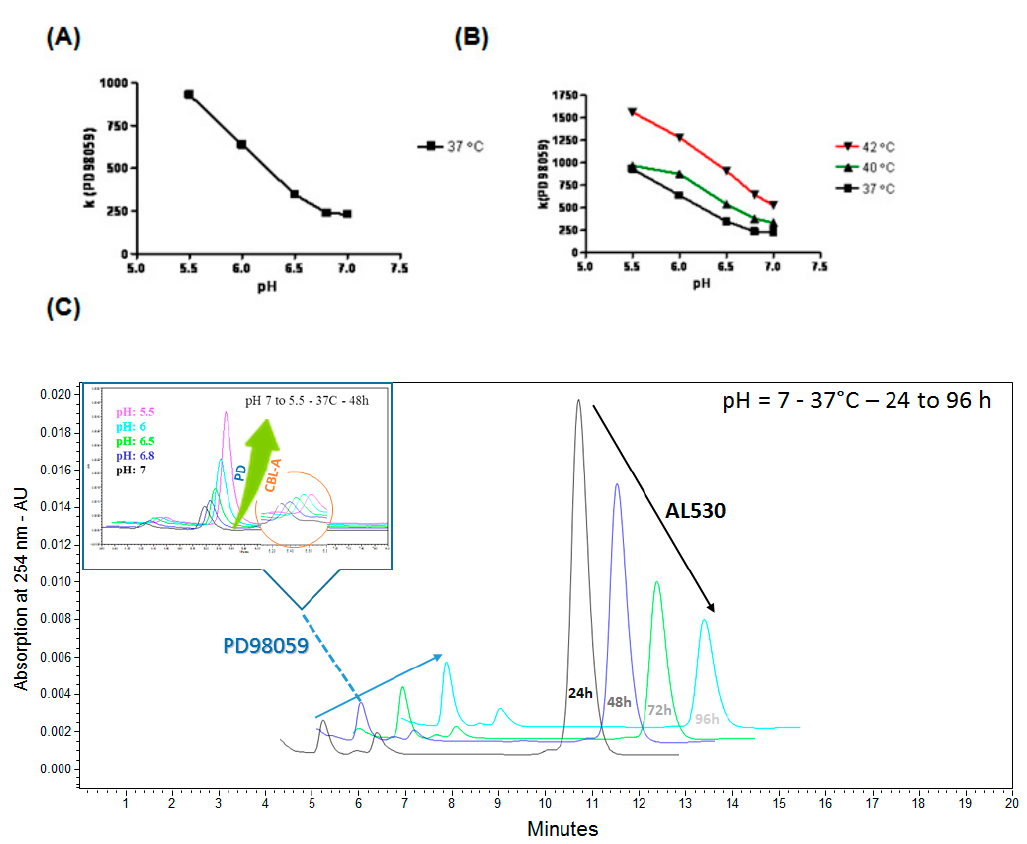
Figure 2. Influence of pH and temperature on AL530 hydrolysis. Graphs ( A ) and ( B ) represent the formation rate (constant k) of PD98059 at (cid:4) —37 ◦ C, (cid:78) —40 ◦ C and (cid:72) —42 ◦ C versus the pH ranging from 5.5 to 7. The overlaid chromatograms ( C ) represent the time course effects (from 24 to 96 h) of AL530 hydrolysis versus the formation of PD98059 at 37 ◦ C at pH = 7.